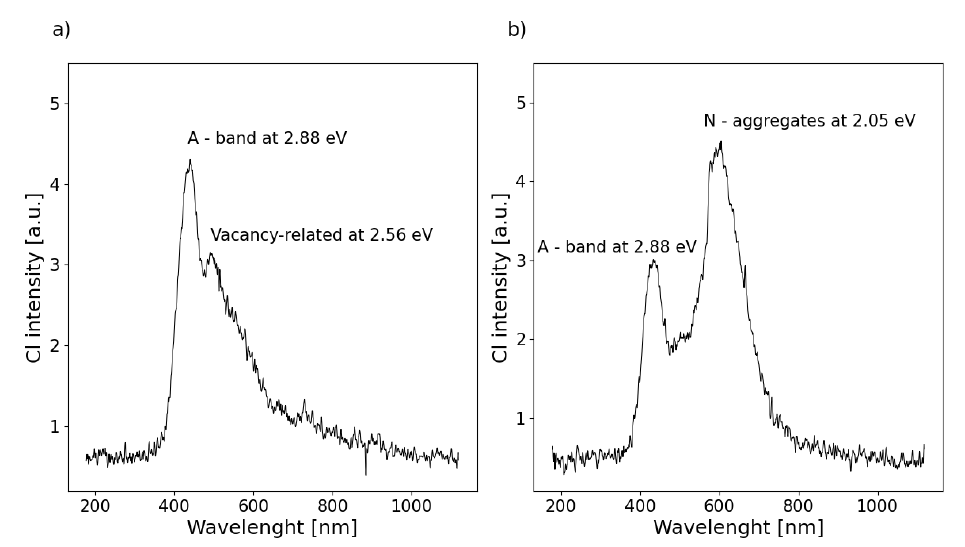
Figure 3. Cathodoluminescence spectra for morphologies of ( a ) DFI and ( b ) DFII diamond layers.